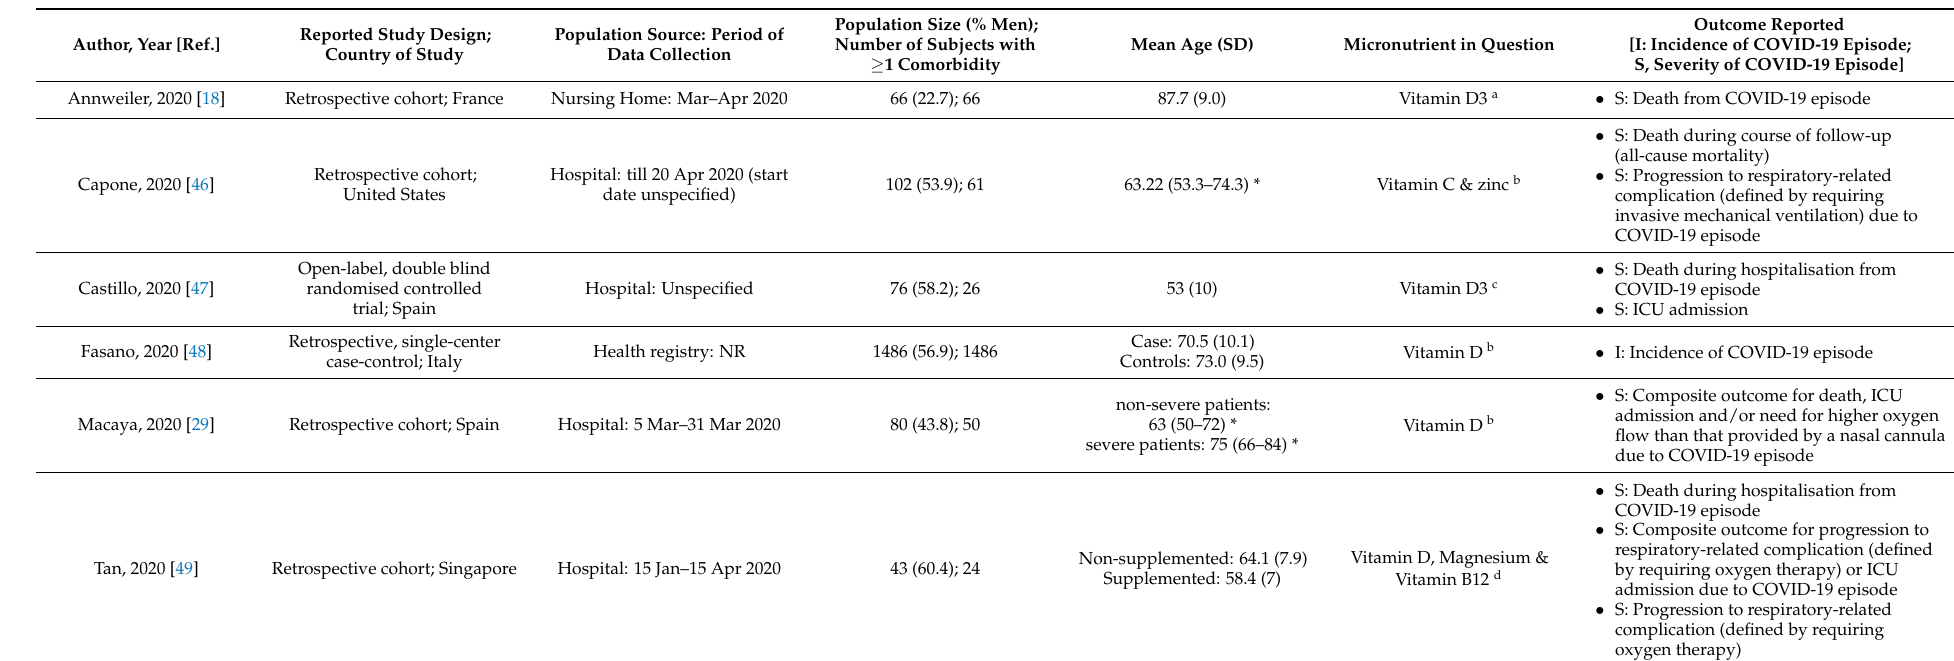
Table 2. Studies assessing micronutrient supplementation on